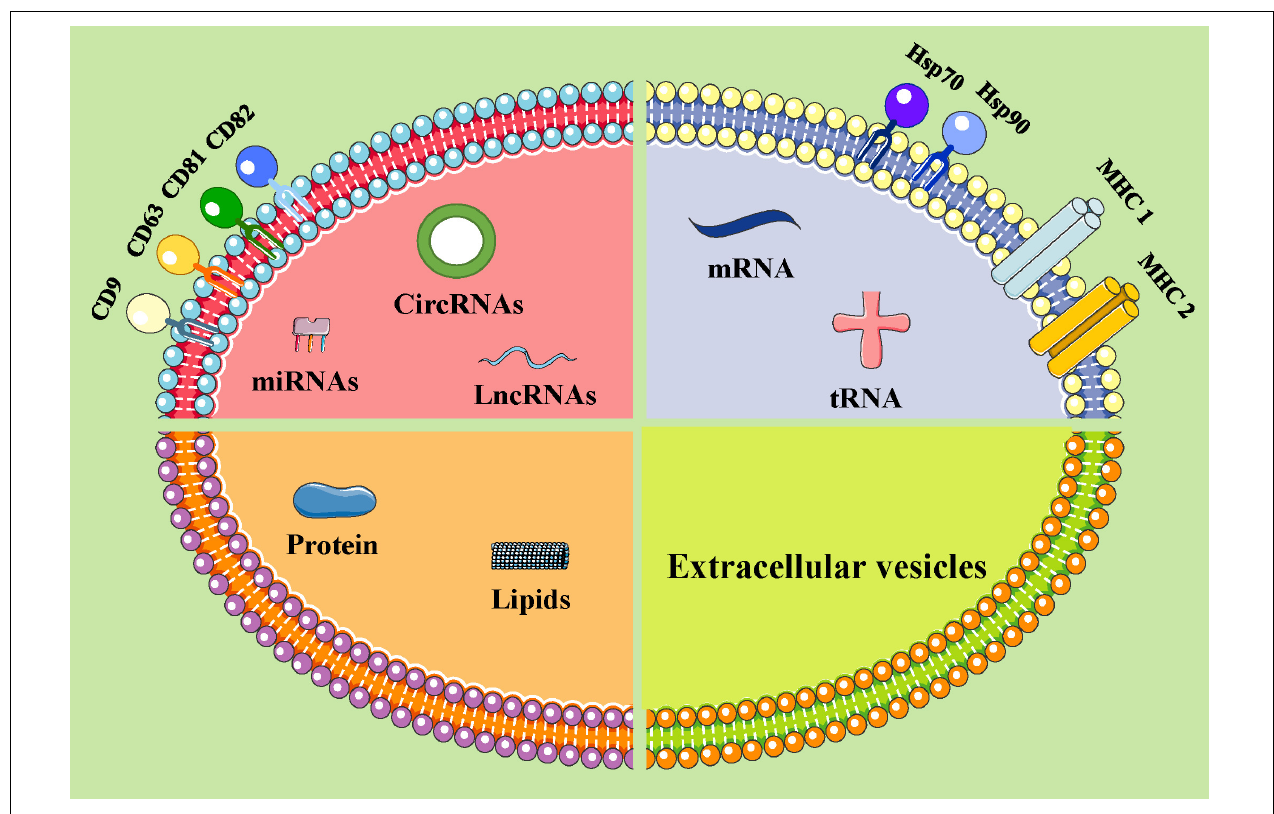
FIGURE 1 | The components of extracellular vesicles (ideograph). EVs can be secreted by various types of cells. EVs carry a variety of proteins, lipids, DNA, mRNA, and non-coding RNAs. Moreover, EV surface proteins contain the following substances: MHC class I/II molecules, heat shock proteins (HSP70, HSP90), and four transmembrane family proteins (CD63, CD9, CD81, and CD82, etc.). miRNAs, microRNAs; lncRNAs, long non-coding RNAs; circRNAs, circular RNAs; mRNAs, messenger RNA; tRNA, transfer RNA.